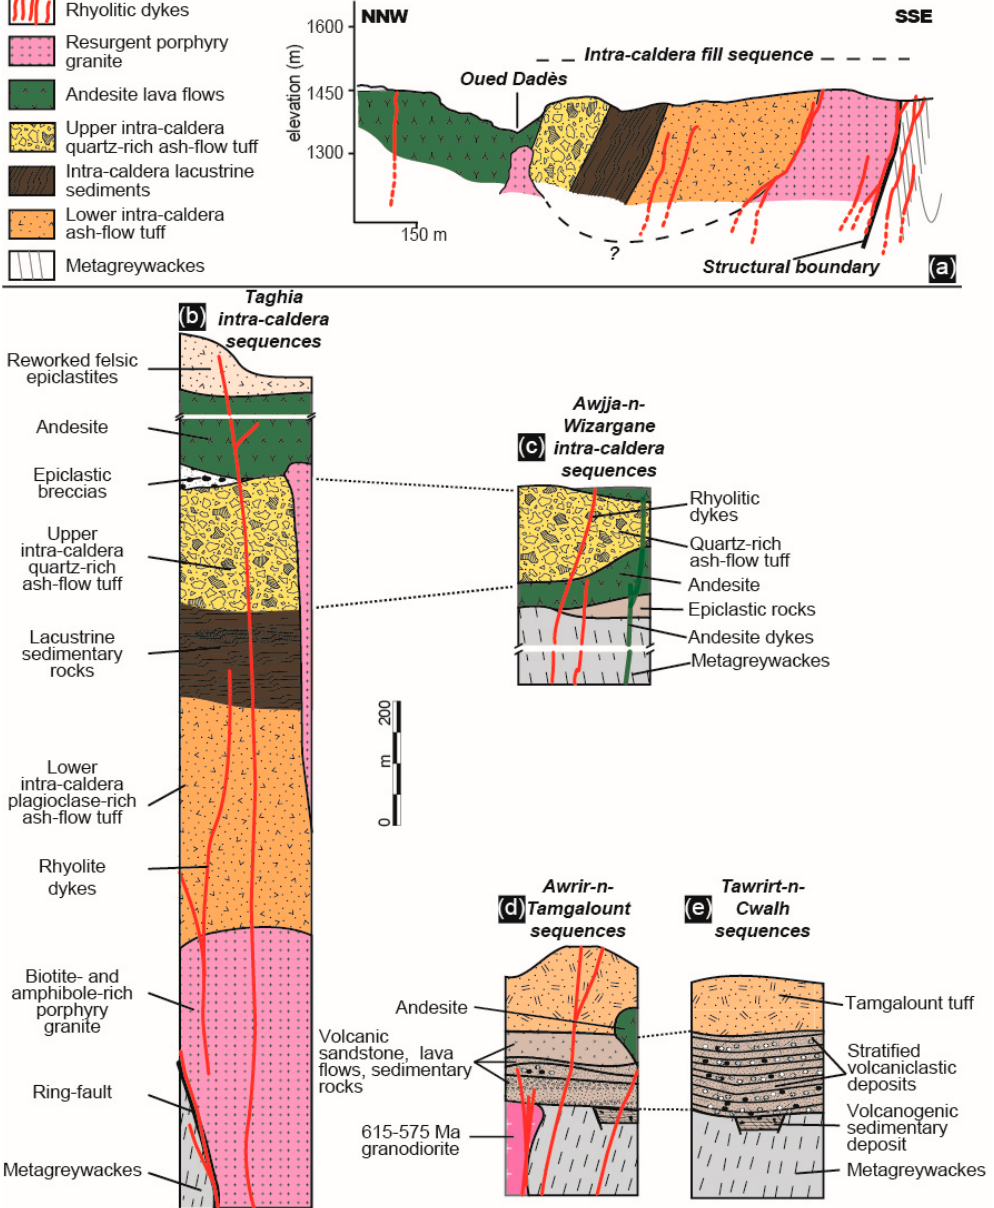
Figure 7. Simplified cross section and graphic logs of the Qal’at Mgouna volcanic sequences according to Tuduri [47]. ( a ) Schematic N–S cross section across the Qal’at MGouna ash-flow caldera. Summary stratigraphic sections for the ( b ) Taghia and ( c ) Awjja-n-Wizargane intra-caldera sequences, and extra-caldera sequences from ( d ) Awrir-n-Tamgalount and ( e ) Tawrirt-n-Cwalh (See location on Figure 5).